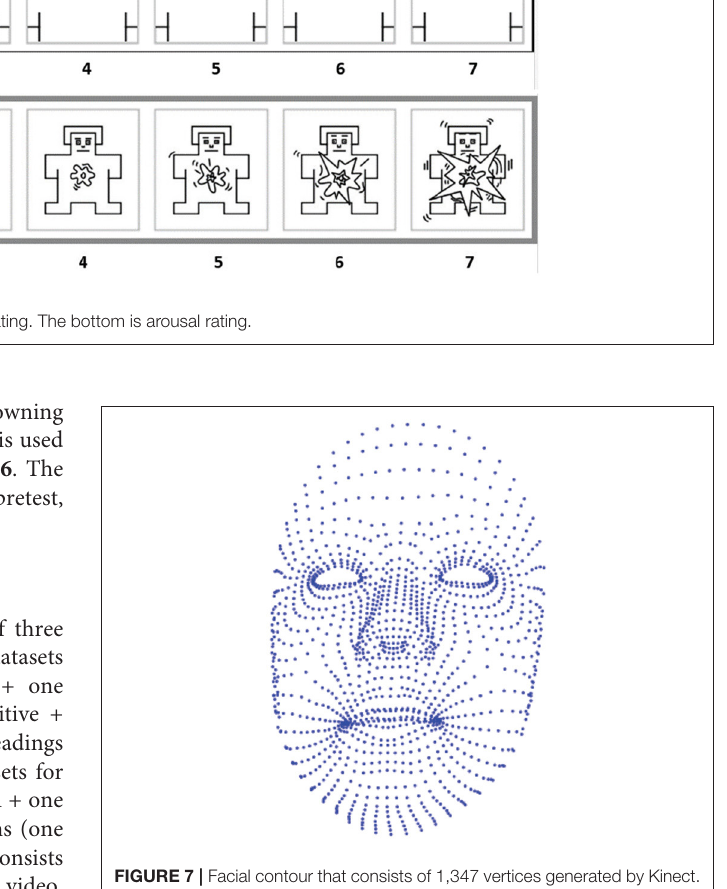
FIGURE 7 | Facial contour that consists of 1,347 vertices generated by